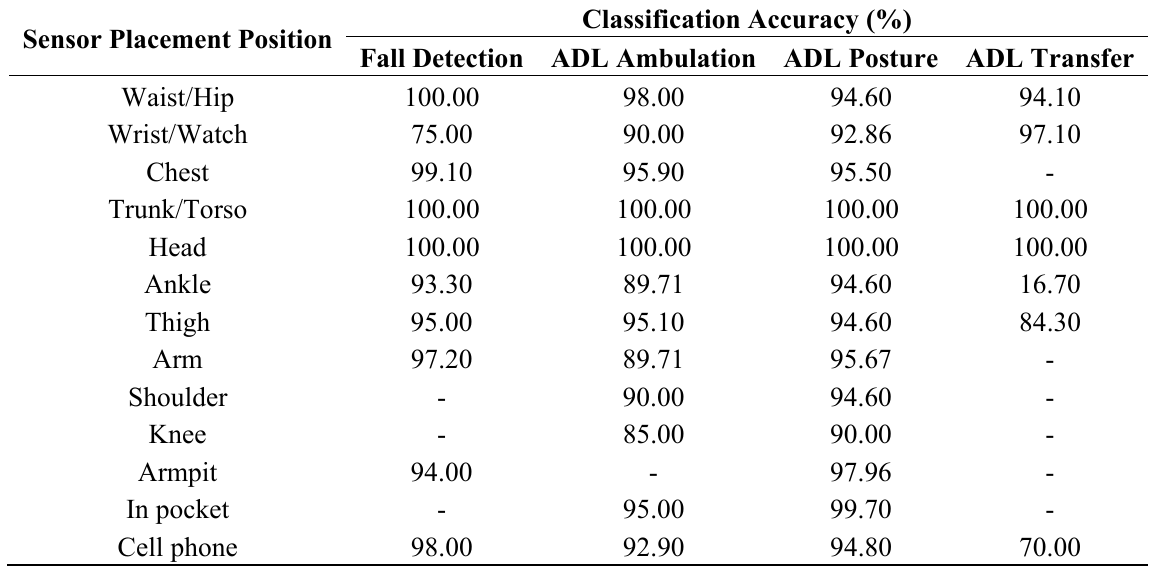
Table 3. Placement positions vs.